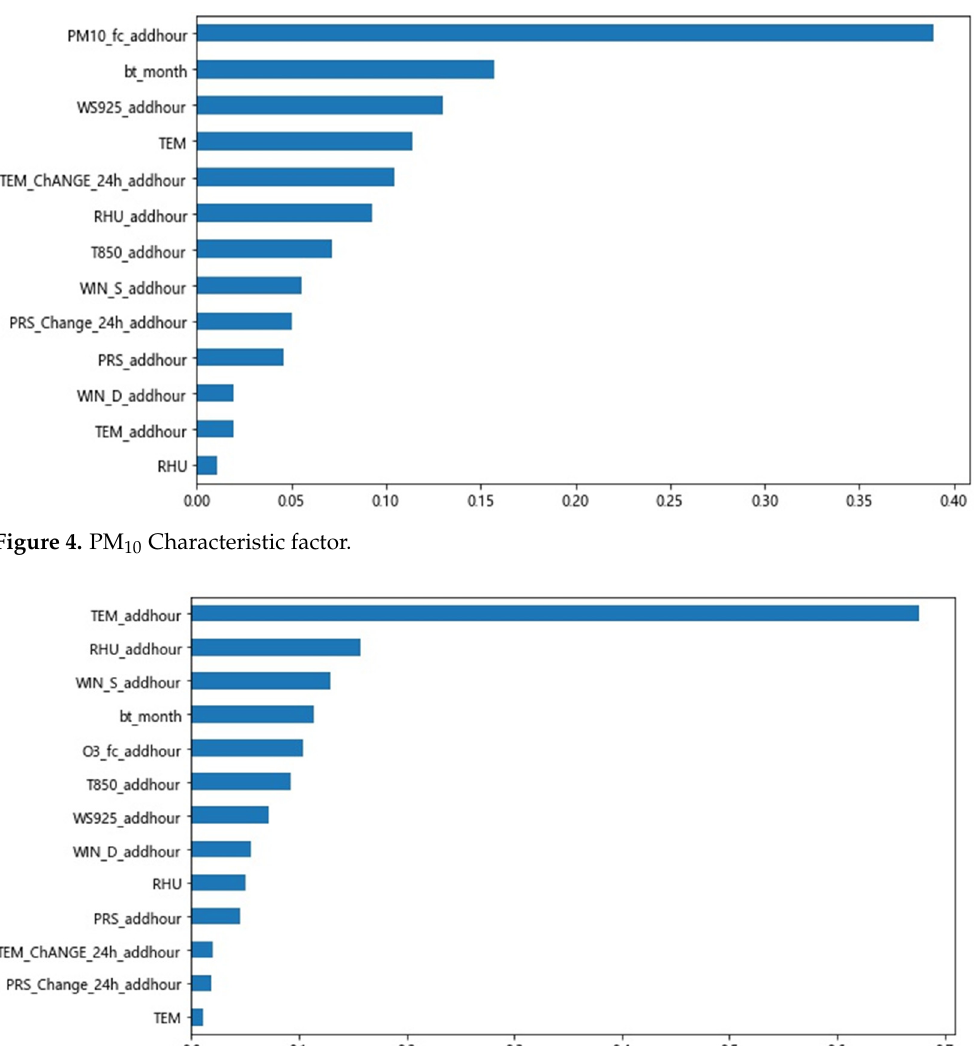
Figure 3. PM 2 . 5 Characteristic factor.